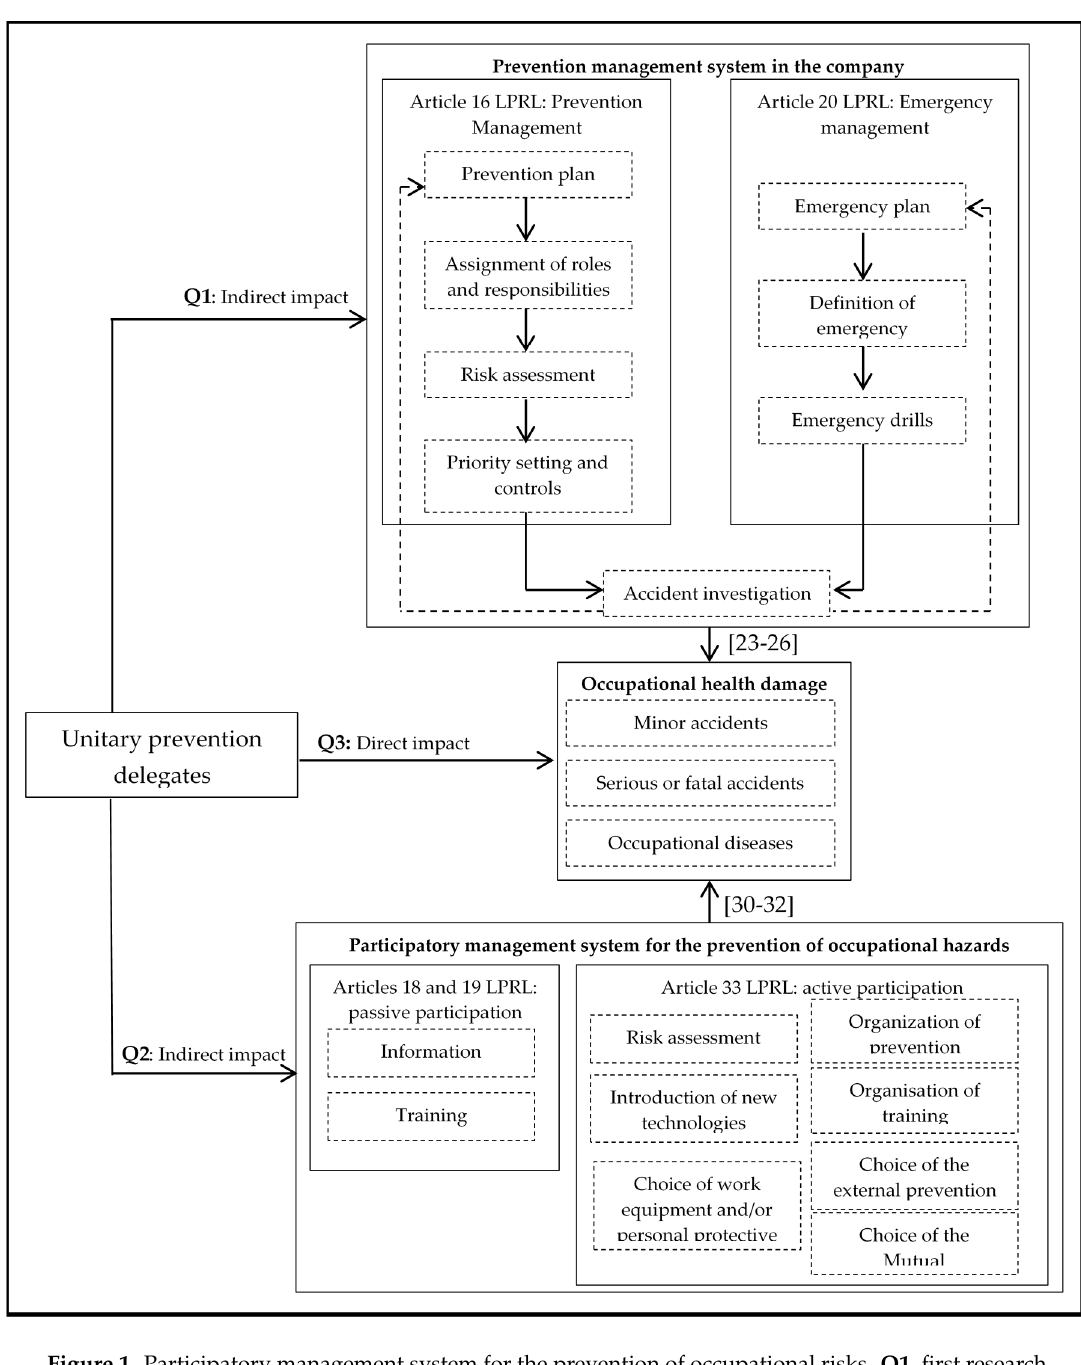
Figure 1. Participatory management system for the prevention of occupational risks. Q1 , first research question; Q2 , second research question; Q3 , third research question; LPRL, Law of 31/1995 on the Prevention of Occupational Risks; [23–26], Number of articles in the bibliographical references that have demonstrated a positive impact of preventive management on accidents; [30–32], number of articles in the bibliographical references that have demonstrated a positive impact of workers’ participation on accidents.